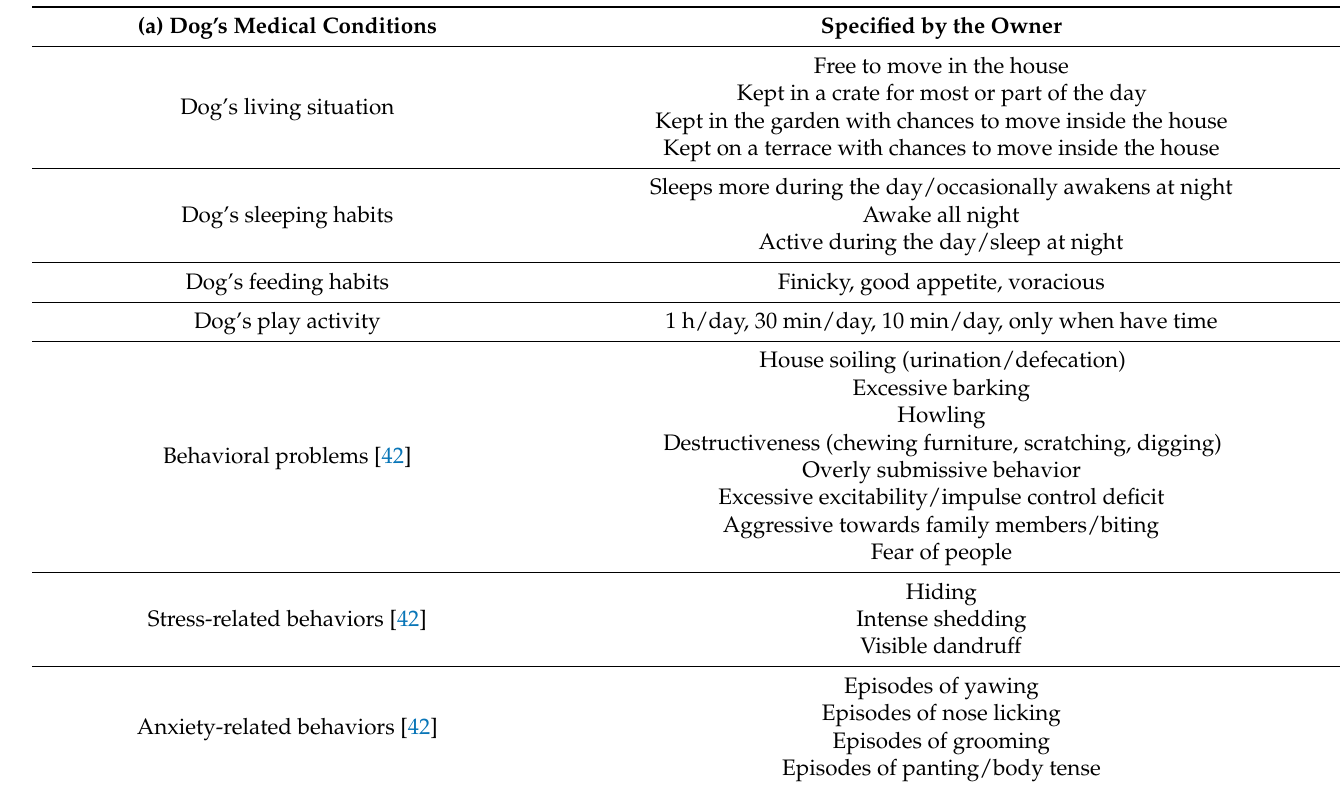
Table 1. List of variables related to the management of the household dogs (a) and cats (b) and the list of behavioral issues, each assessed BL and